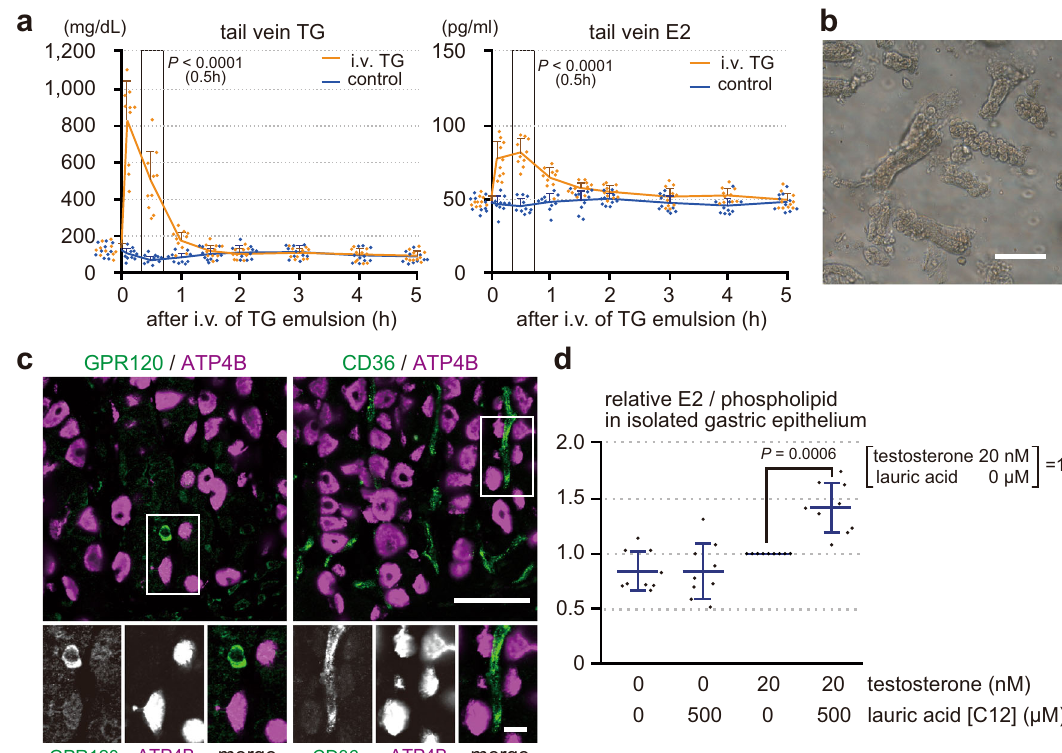
Fig. 4 Blood estrogen levels and production of gastric estrogen are directly regulated by blood triglyceride levels in males. a Male rats (8 weeks old, deprived of food for 4 h) were intravenously injected with soy oil emulsion (2 mL of 20 % soy oil emulsion per kg body weight, n = 10) or control saline (control, n = 10). TG and E2 levels in the tail venous blood were measured before (0) and at 0.1, 0.5, 1, 1.5, 2, 3, 4, and 5 h after the injection. b Isolated gastric gland epithelium from male rats. c Gastric mucosa of the male rat was double-stained for GPR120 (G-protein-coupled receptor 120) or CD36 (cluster of differentiation 36) (green) with ATP4B (magenta). d Isolated epithelium from male rat (deprived of food for 4 h) was incubated in DMEM with or without testosterone (20 nM) or lauric acid (500 µ M) at 37 °C for 1 h. E2 levels, normalized by phospholipid, were compared to those incubated with 20 nM testosterone but without lauric acid ( n = 9). n number of rats. Data were mean ± s.d. a (0.5 h) and d , P values determined by two-sided Student ’ s t -test. Bars: (main panels) 50 µ m; (insets) 10 µ